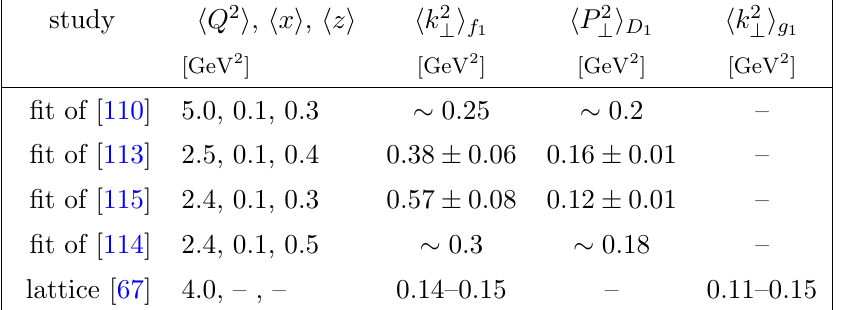
( x; k 2 ), D a ( z; P 2 ), g a ( x; k 2 ) from phenomenological 1 1 1 ? ? ?